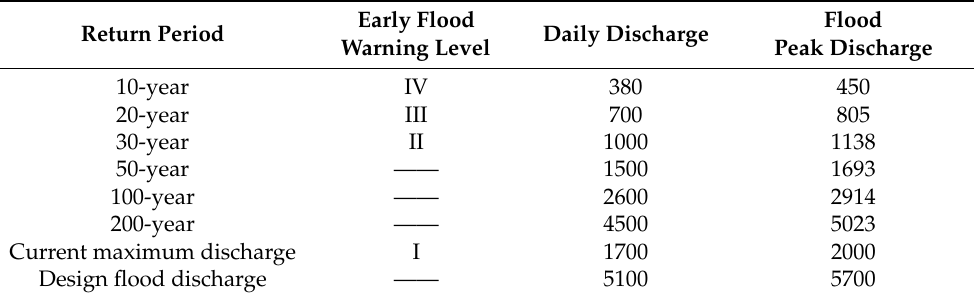
Table 1. Daily discharges and the corresponding flood peak discharge in different return periods in the Zhulong river watershed (m 3 /s).